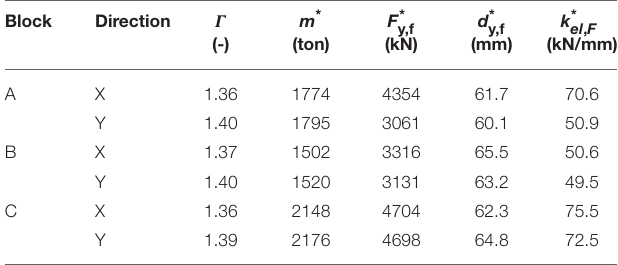
TABLE 3 | Equivalent SDOF parameters of the bare frames of the three blocks in both horizontal directions.